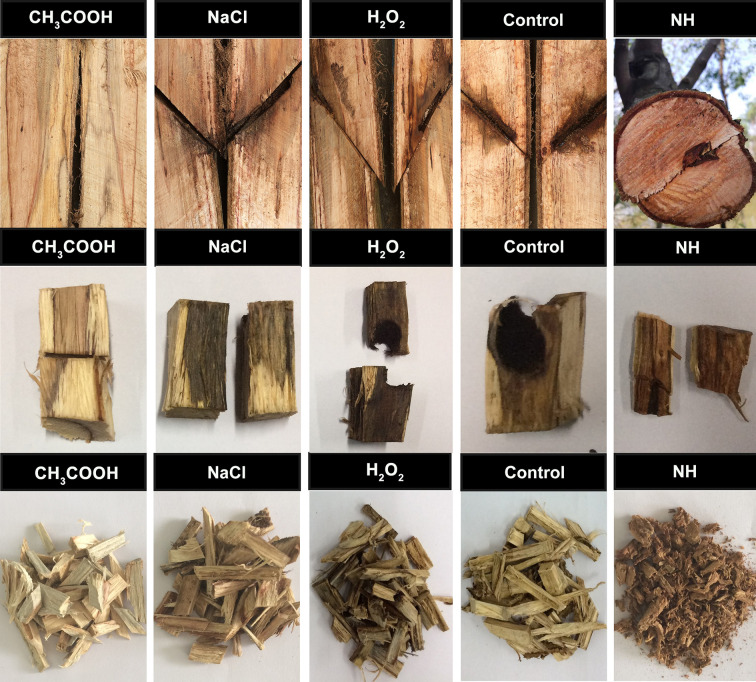
Image description of Jiang Xiang of Dalbergia odorifera. The images from left to right represent CH3COOH, NaCl, H2O2 and wounding induced Jiang Xiang (discolored wood), respectively. NH represents the natural heartwood (wild Jiang Xiang), which forms very slowly.